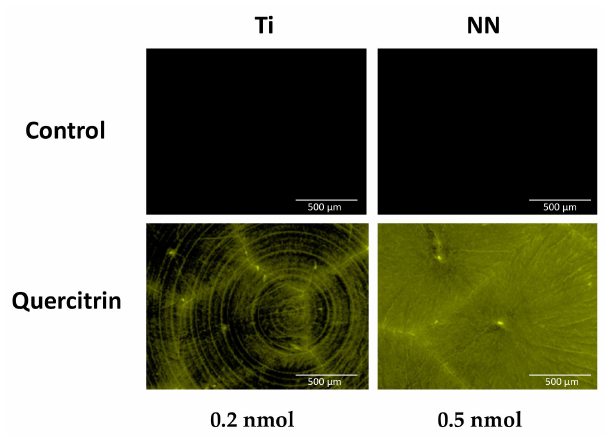
Figure 2. Quercitrin functionalized titanium surfaces staining. Representative fluorescence images of the quercitrin functionalized titanium surfaces after a fluorescence staining. 0.2 ± 0.1 nmol of QR were immobilized for the TiQR group while up to 0.5 ± 0.2 nmol of QR could be detected for the NNQR